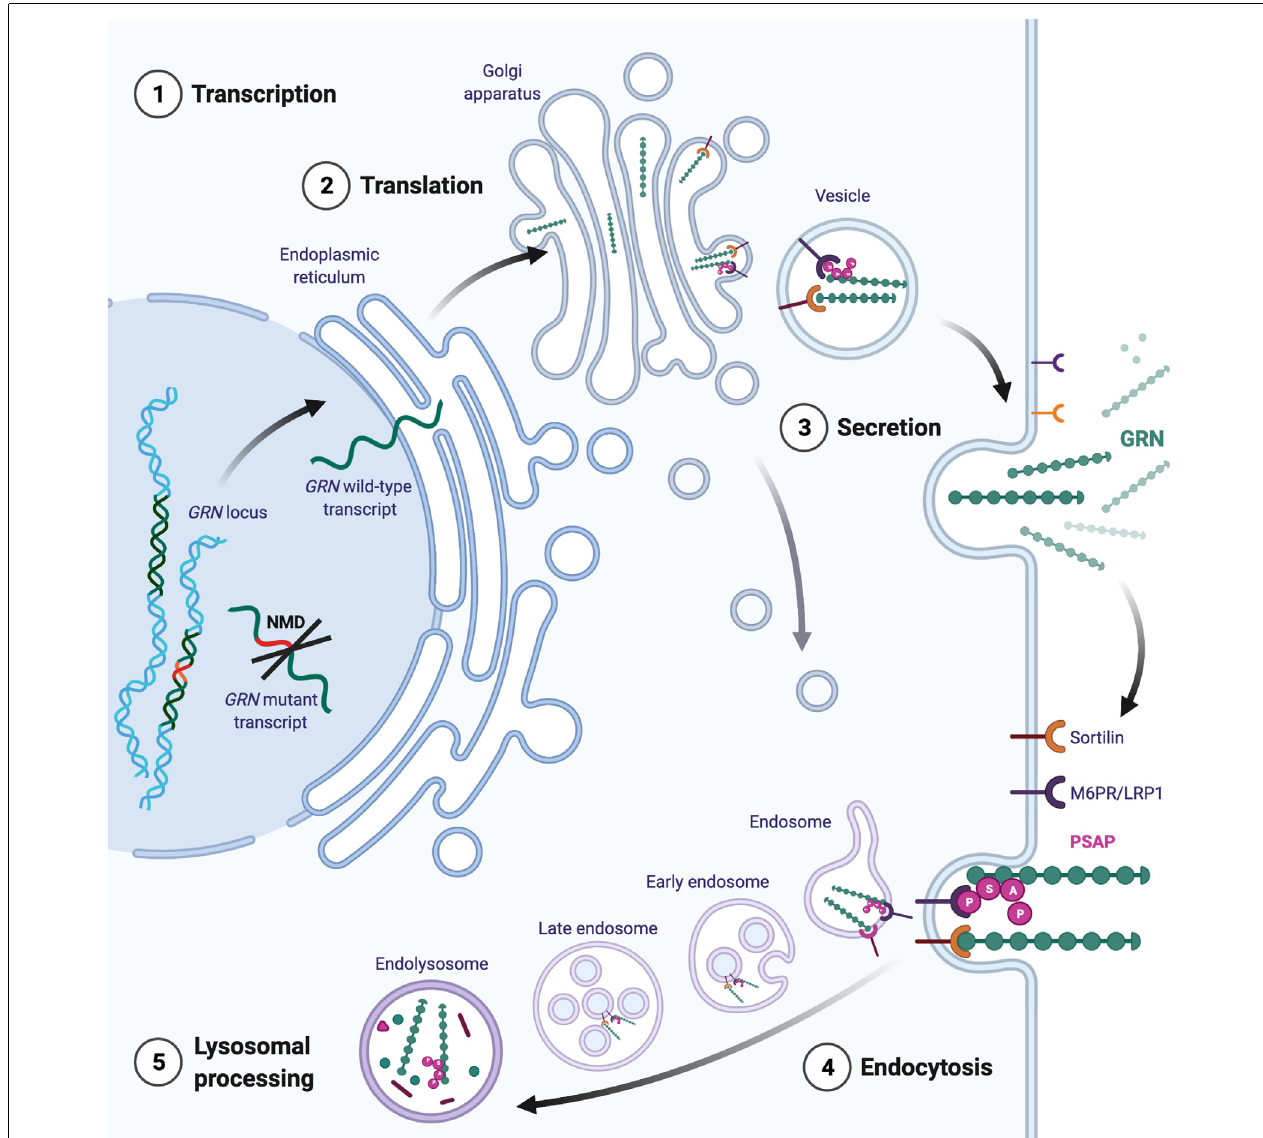
FIGURE 2 | Intracellular trafficking of GRN. Transcripts from the mutated GRN allele are generally removed by nonsense-mediated mRNA decay (NMD). Transcripts from the healthy allele are translated directly into the endoplasmatic reticulum, where chaperones ensure proper folding. Mature GRN can be secreted constitutively or in an activity- dependent manner (for example in neurons). Extracellularly, GRN initiates tissue- and cell-type-dependent autocrine and paracrine signaling cascades. GRN binding partners are omitted for simplicity. Extracellular GRN levels are regulated through proteolytic degradation and by endocytosis. The binding of GRN to sortilin facilitates the uptake of GRN to endosomes. Alternatively, GRN can traffic to the endosome by indirect binding of the mannose-6-phosphate receptor (M6P) via prosaposin (PSAP). Additionally, GRN is thought to travel directly to the endosomal system via the trans-Golgi